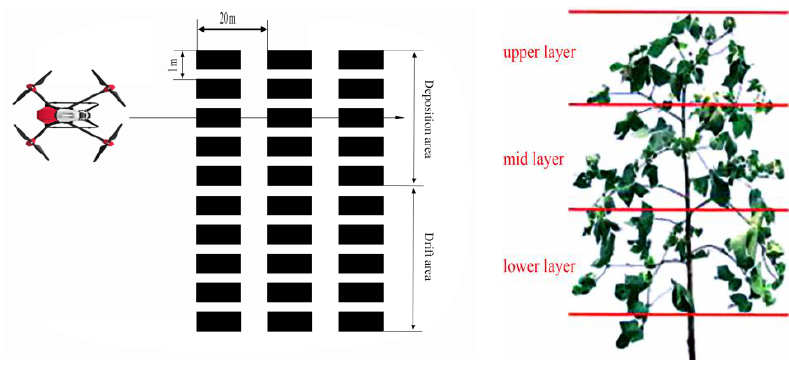
Figure 2. Arrangement of kromekote cards and filter paper.